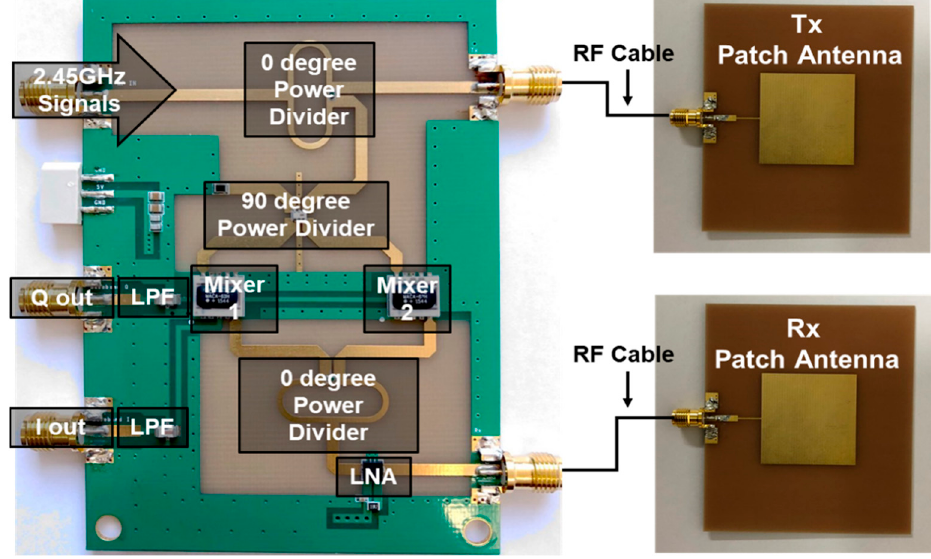
Figure 5. A 2.45-GHz quadrature continuous-wave Doppler radar sensor for vital signs detection.